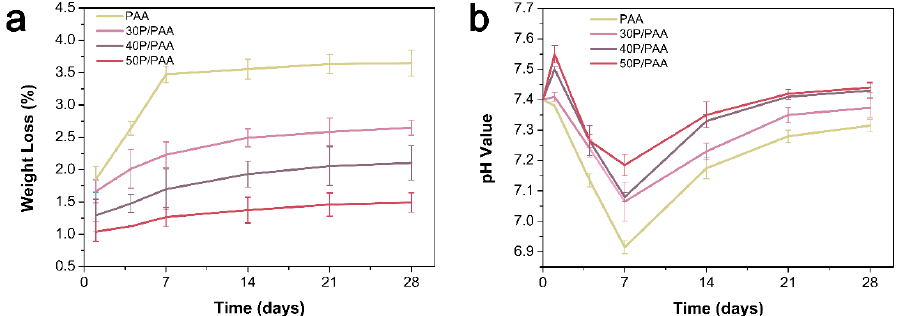
Figure 4. Weight loss ( a ) of the PAA and composites and pH variation ( b ) of the medium after soaking in PBS for different